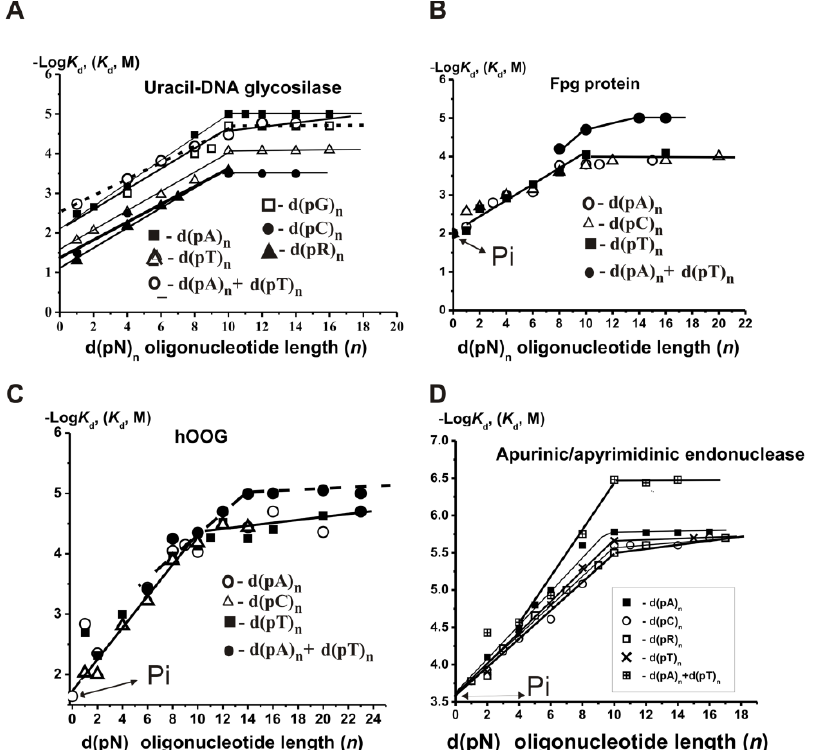
Figure 3. Dependencies of –Log K d for ss and ds d(pN) n deoxyribooligonucleotides versus their length ( n ) in the case of uracil DNA glycosylase ( A ) [26,27], Fpg protein ( B ) [54–57], hOGG1 ( C ) [59], and apurinic/apyrimidinic endonuclease ( D ) [69]. All oligonucleotides used are shown in panel ( A – D ); d(pR) n oligomers do not contain any bases.